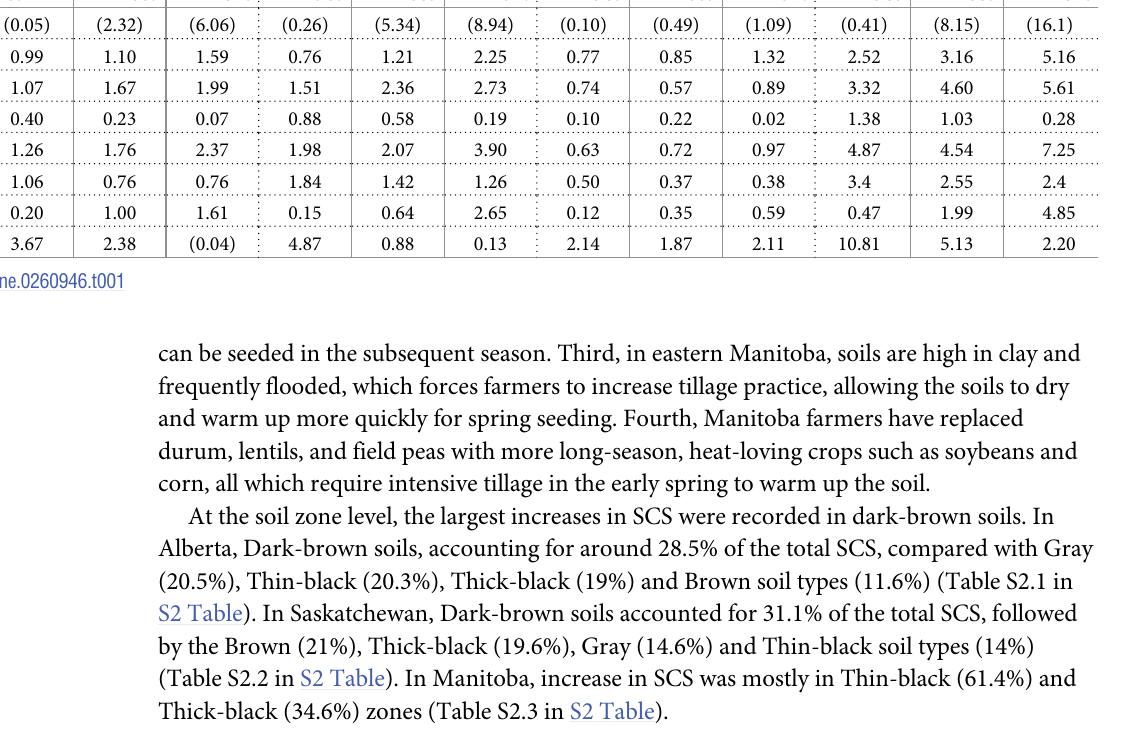
Thick-black (34.6%) zones (Table S2.3 in S2 Table).